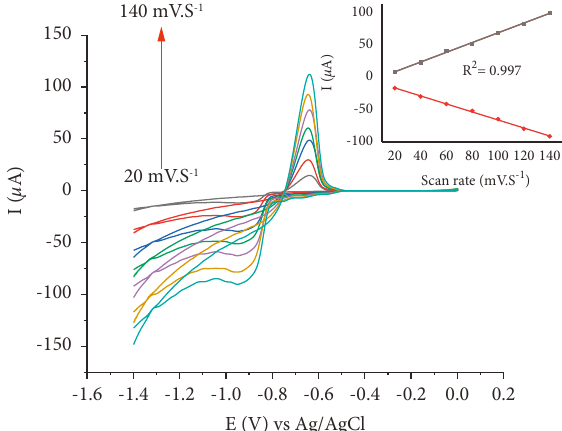
Figure 13: Cyclic voltammograms of 100nM Cd(II) in 0.1 M B-R buffer of pH 4 at HDPBA-CPE with different scan rates (bottom to top: 20, 40, 60, 80, 100, 120, and 140mV · S − 1 ). Inset: plot for the peak currents of Cd(II) vs ] .